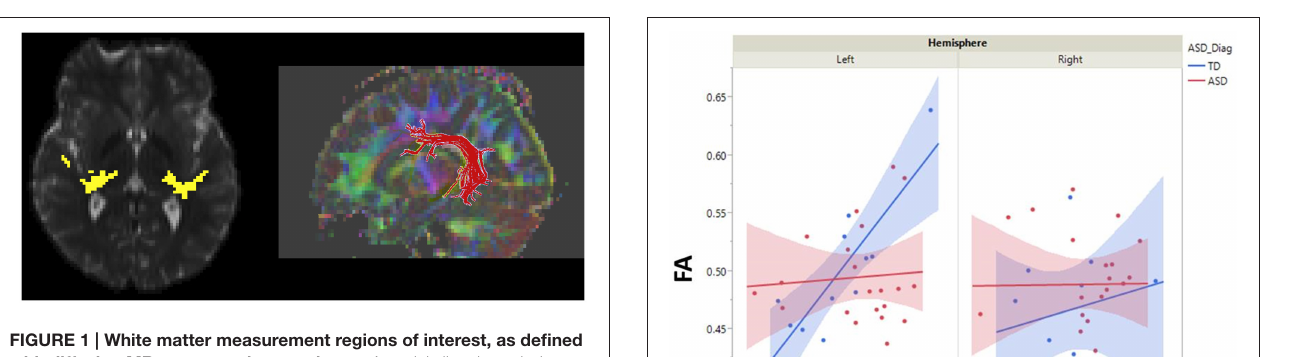
group by age difference. The slower maturation of FA in ASD was likely due to a slower rate of RD decrease in ASD vs.